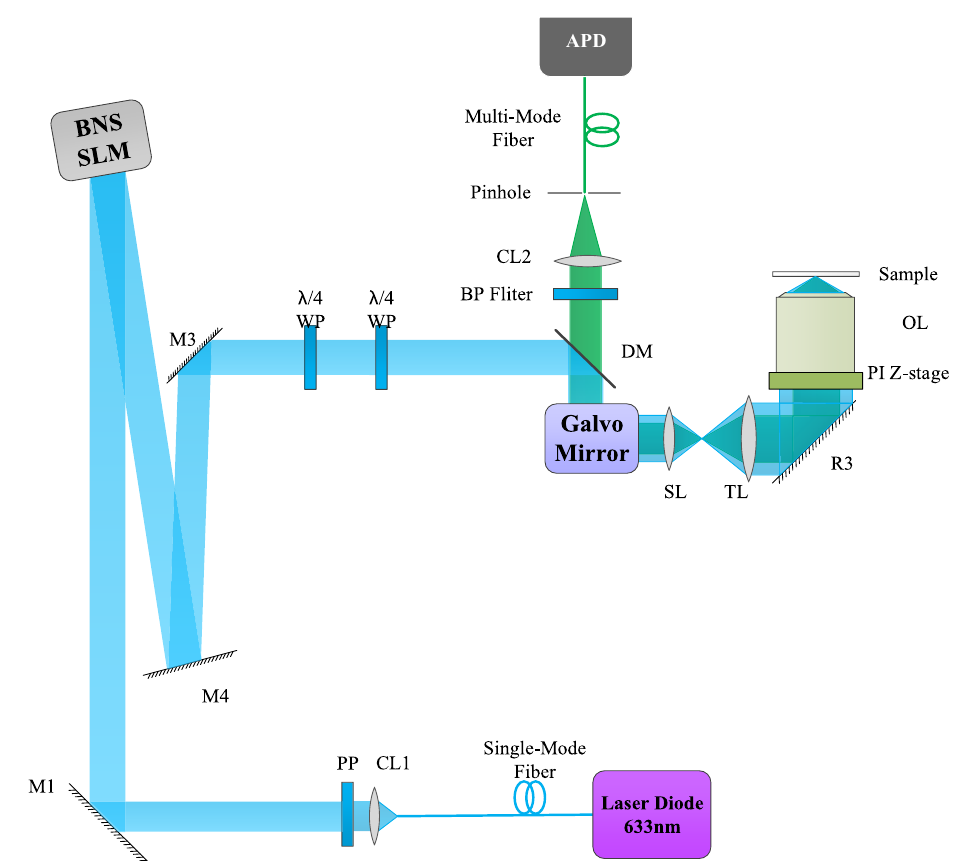
Fig. 4. Con¯guration of a 3D-FED microscopy system. CL1-collimating lens, (cid:5) /4WP- (cid:5) /4 wave plate, PBS-polarizing beam splitter, M-re°ecting mirror, BNS SLM-BNS phase only SLM, BP ¯lter-bandpass ¯lter, DM, SL, TL, OL, CL2-convergent lens, APD-avalanche photon